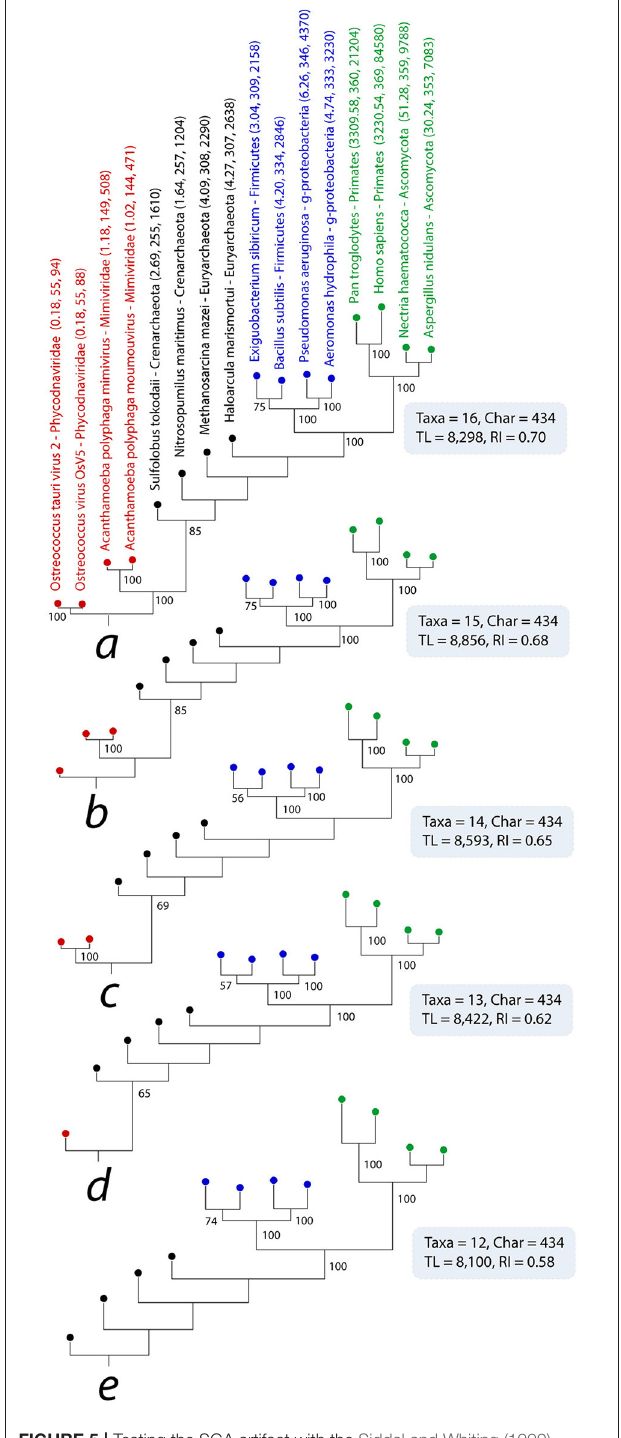
FIGURE 5 | Testing the SGA artifact with the Siddal and Whiting (1999) approach. A single most parsimonious phylogenomic tree ( a ) describes the evolutionary relationships between four proteomes sampled each from viruses, Archaea, Bacteria, and Eukarya. Taxa are colored as previously described. Numbers on branches indicated BS support values (%). Single most parsimonious trees b through e were recovered after successive elimination of the smallest viral proteomes. TL, tree length; RI, retention